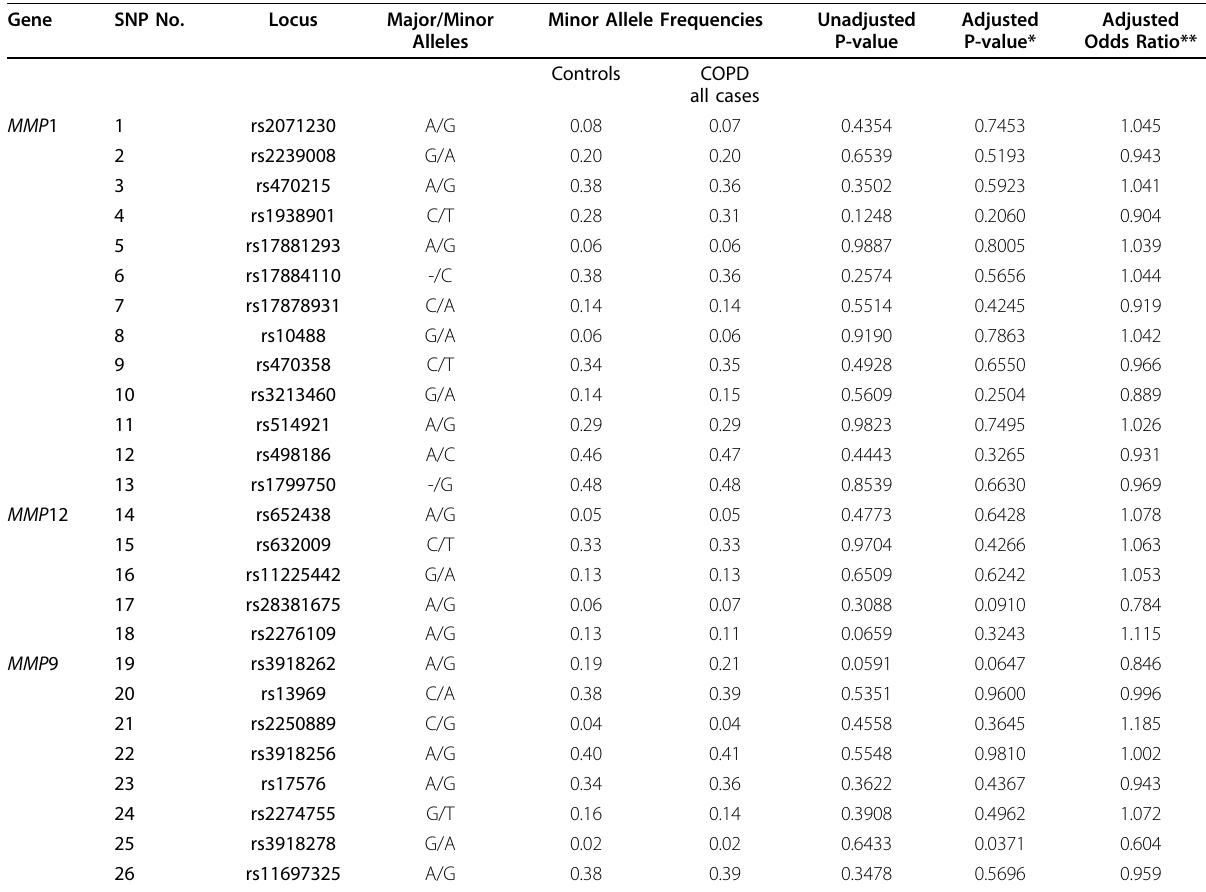
Table 6 MMP s - 1, 12 and 9 - Allelic frequencies in Controls and Cases Gene SNP No. Locus